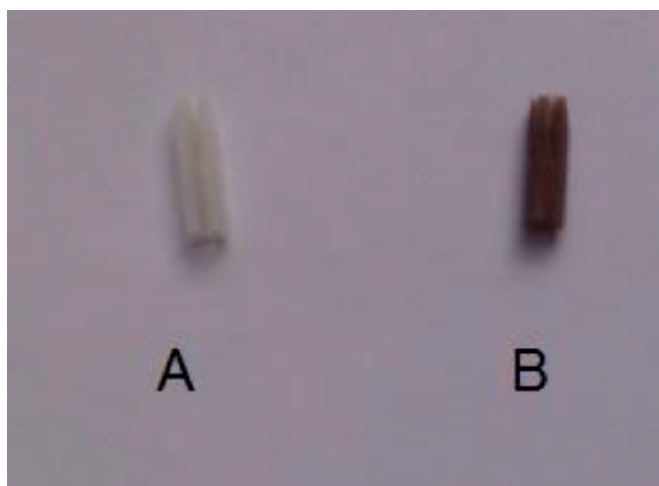
Figure 1. Catheter sample untreated ( a ) and porphyrin-coated ( b ).